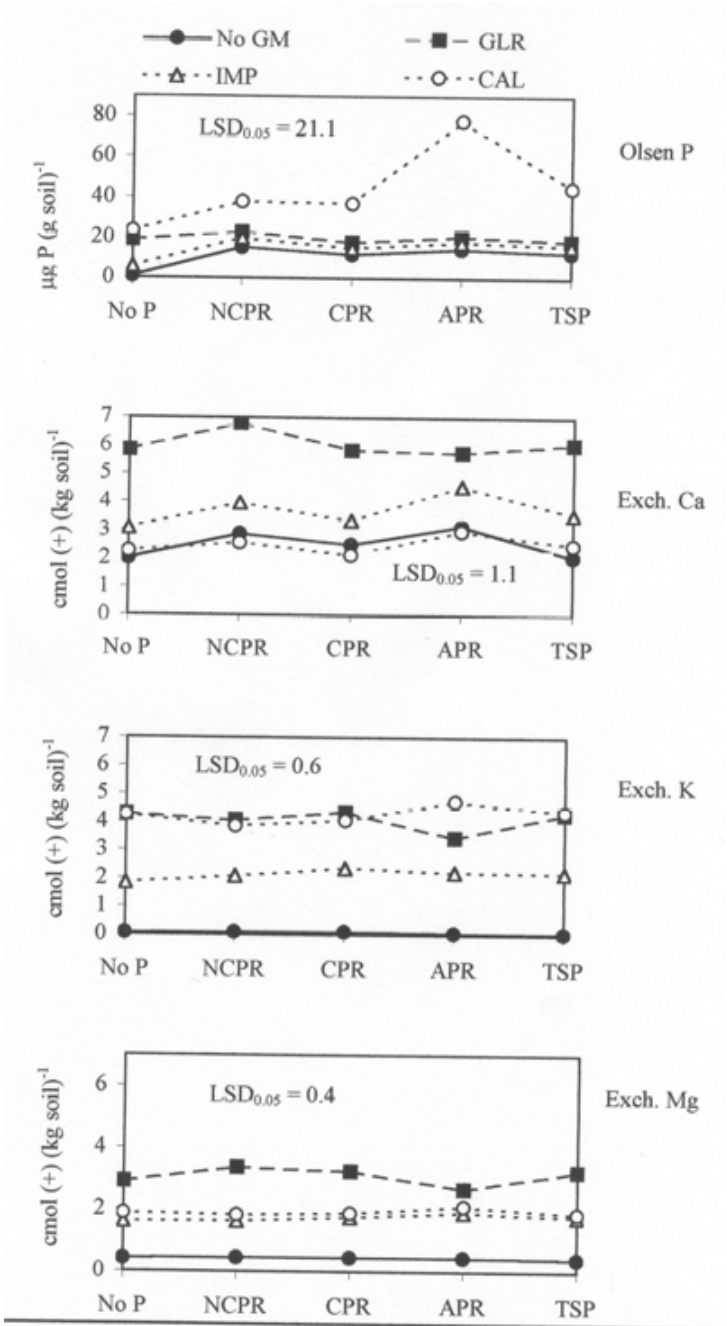
FIGURE 8 . Nutrient levels in a tropical soil treated with GMs and inorganic P fertilizers after incubation for 64 weeks.